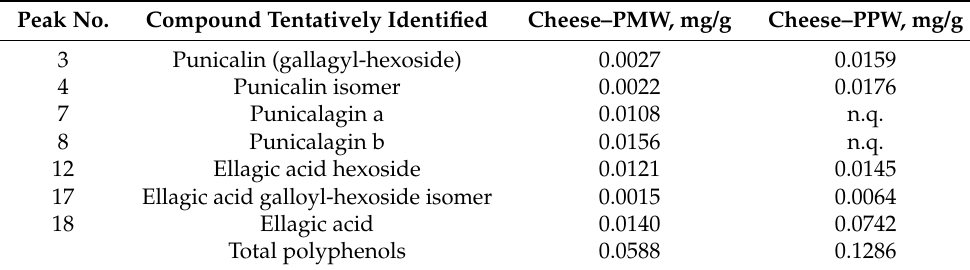
Table 4. Polyphenol content in experimental pomegranate-enriched cheese samples. N.q. = not quantified. Peak